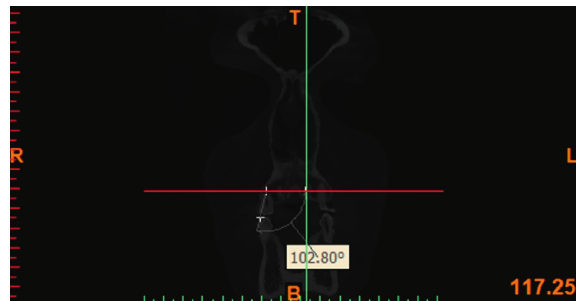
Figure 4: Measuring the inclination of maxillary canines.